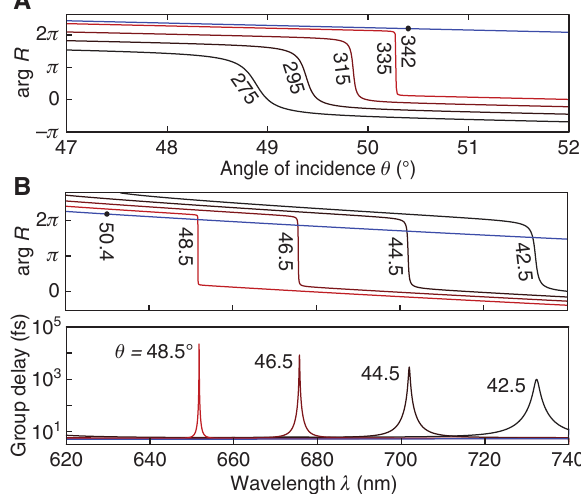
Figure 3: Phase of the reflected TE-polarized mode (arg R ) vs. angle of incidence θ at different ridge widths w = 275, 295, 315, 335, and 342 nm at λ = 630 nm (A) and arg R (B, upper panel) and group delay (B, lower panel) vs. wavelength λ at different angles of incidence θ = 42.5 ° , 44.5 ° , 46.5 ° , 48.5 ° , and 50.4 ° at w = 342 nm calculated using AFMM. The BIC condition is shown with black circles.